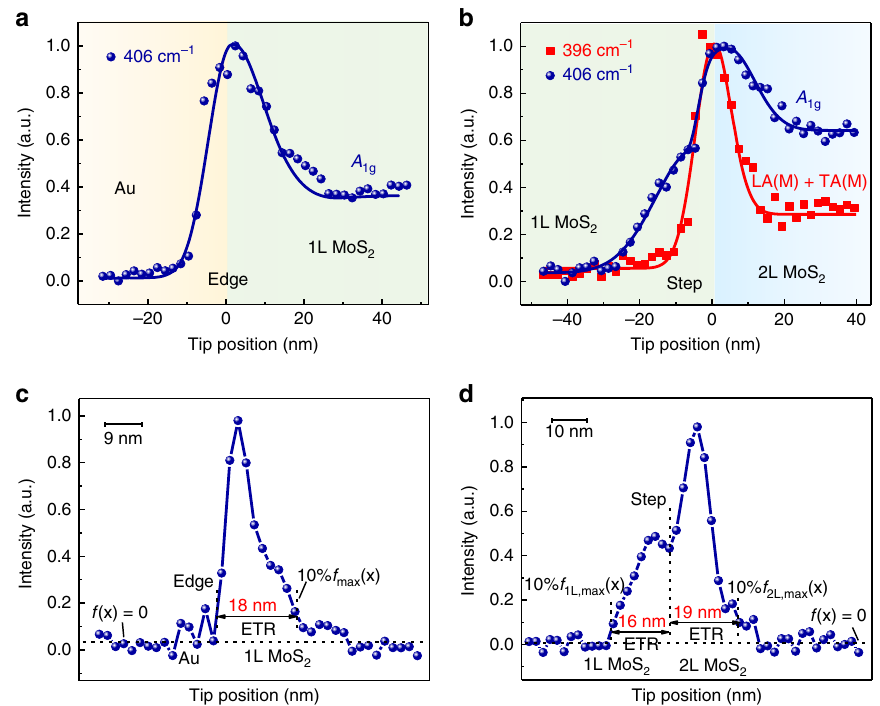
Fig. 4 ETRs induced by 1 L edge and 1 – 2 L step. a , b Plots of normalized intensities of TERS peaks with the tip positions across the 1 L edge ( a ) and 1 – 2 L step ( b ). The solid lines are the fi tted results. See Supplementary Note 2 for details about the data fi tting. Note that these spectra are the pure near- fi eld signals and have been subtracted with the far- fi eld signals. Supplementary Fig. 20b, cshows more data sets for the corresponding line-trace TERS spectra. Enhanced TERS intensity pro fi les of the ETR in 1 L edge ( c ) and 1 – 2 L step ( d ) after the deconvolution of the EM fi eld intensity distribution (see Supplementary Note 2 for more